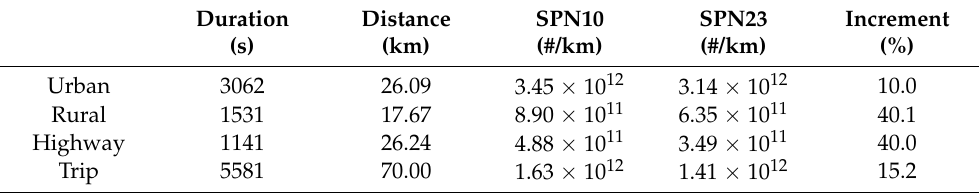
Table 4. Distance-based PN results of SPN23 and SPN10 over the laboratory RDE